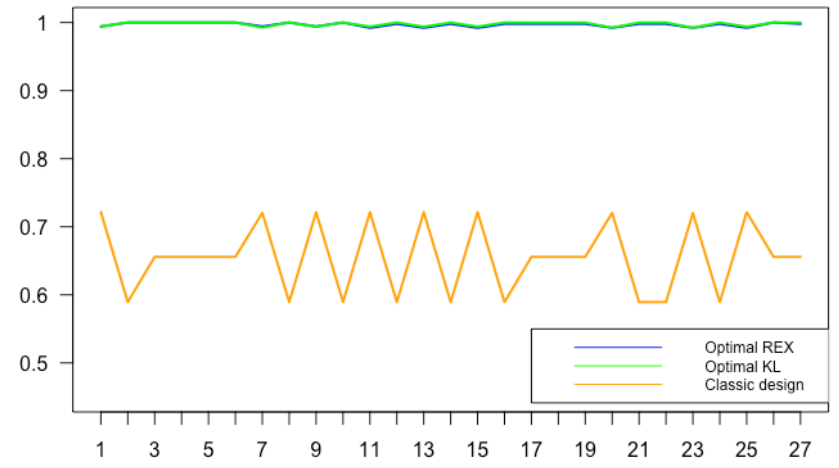
Figure 7. Efficiencies of the 27 possible